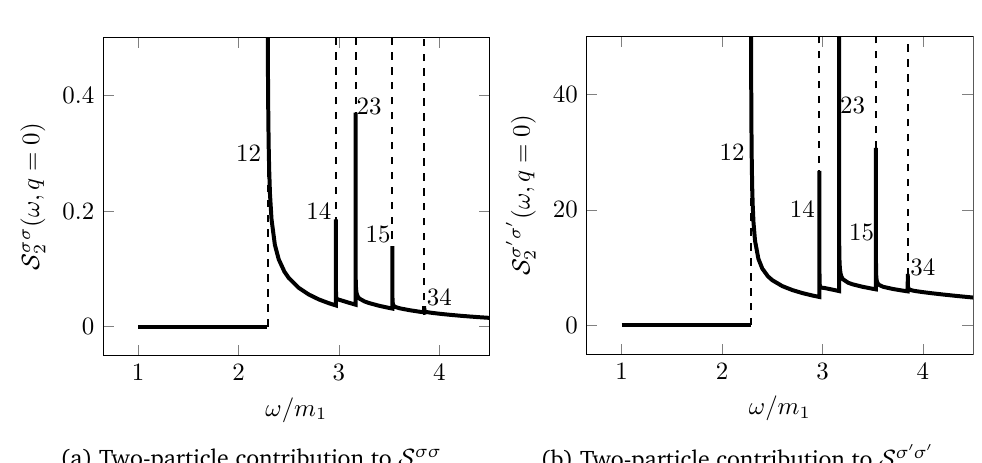
Figure 7.1: Two-particle contributions to the dynamical structure factor of the lead- ing and subleading magnetisation operators. The values of the dynamical structure factors are shown in units of the massgap m using the exact VEV (5.21). 1